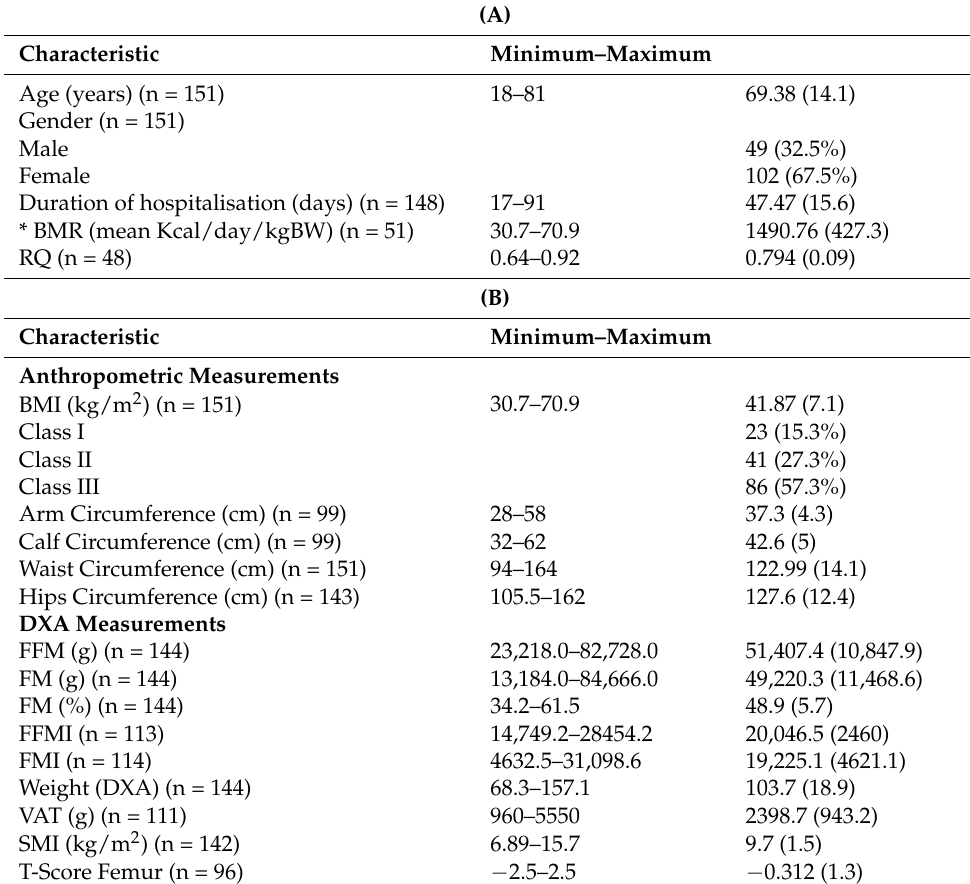
Table 1. ( A ) Baseline demographic characteristics of the study group. ( B ) Baseline anthropometric and body measurements of the study group. ( C ) Baseline nutritional and inflammatory parameters of the study group. ( D ) Baseline serum metabolites, electrolytes ions and lipids of the study group. ( E ) Baseline serum enzymes and hormones of the study group. ( F ) Baseline haematological parameters of the study